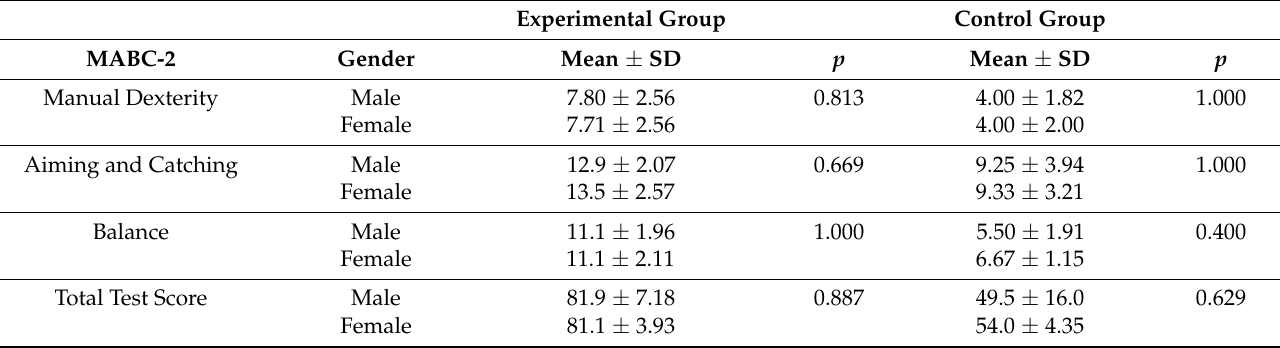
Table 7. Post-intervention. Gender effect in each group at MABC-2